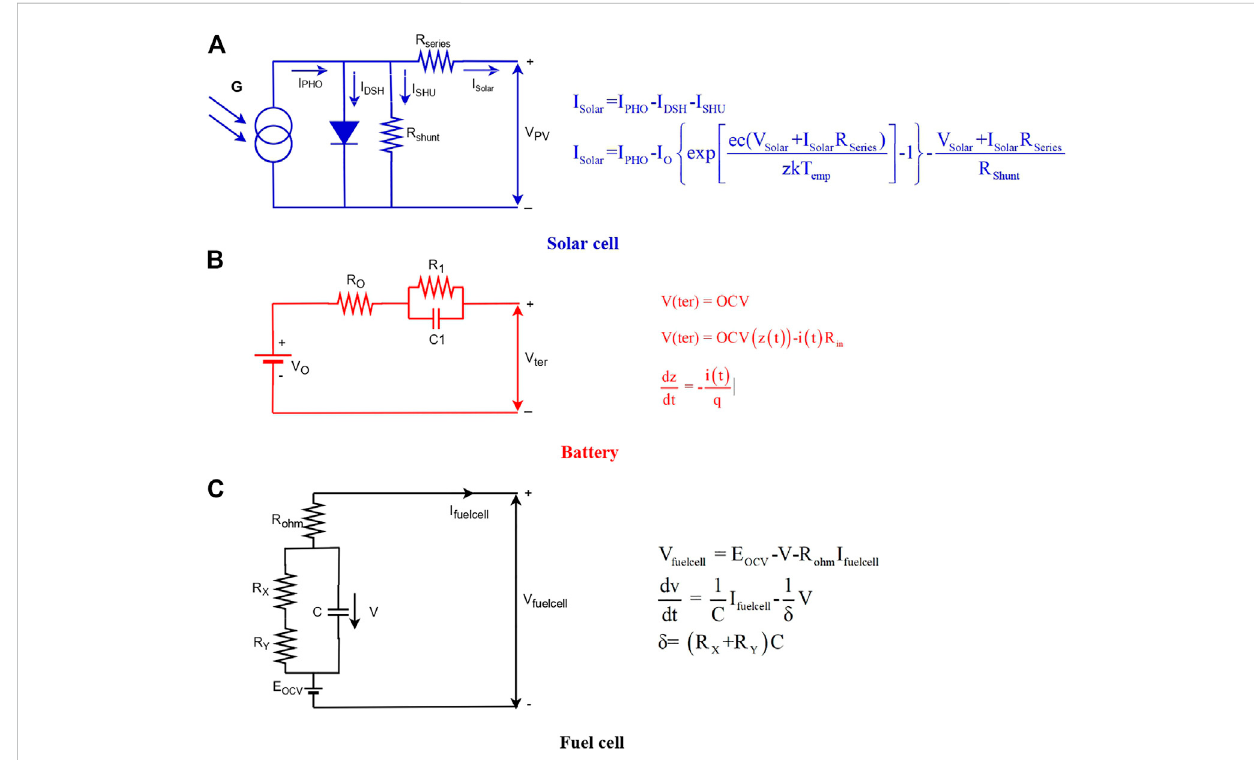
FIGURE 3 Equivalent circuit of input sources (A) solar cell, (B) battery, and (C) fuel cell in the proposed work.